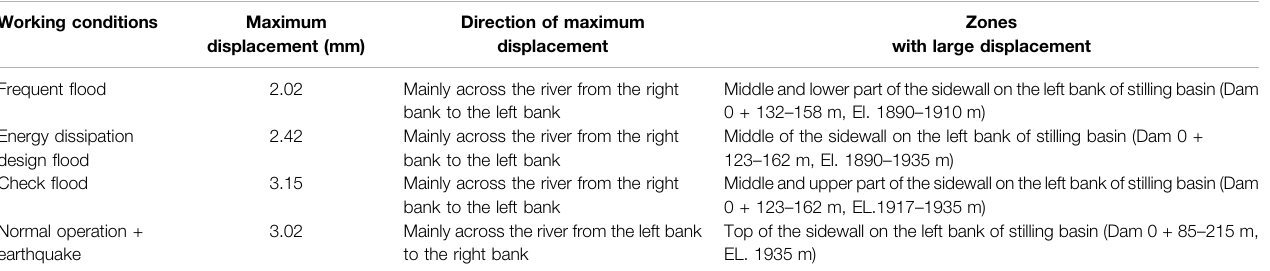
TABLE 3 | Numerical modelling results of displacements of stilling basin under 4 types of working conditions. Working